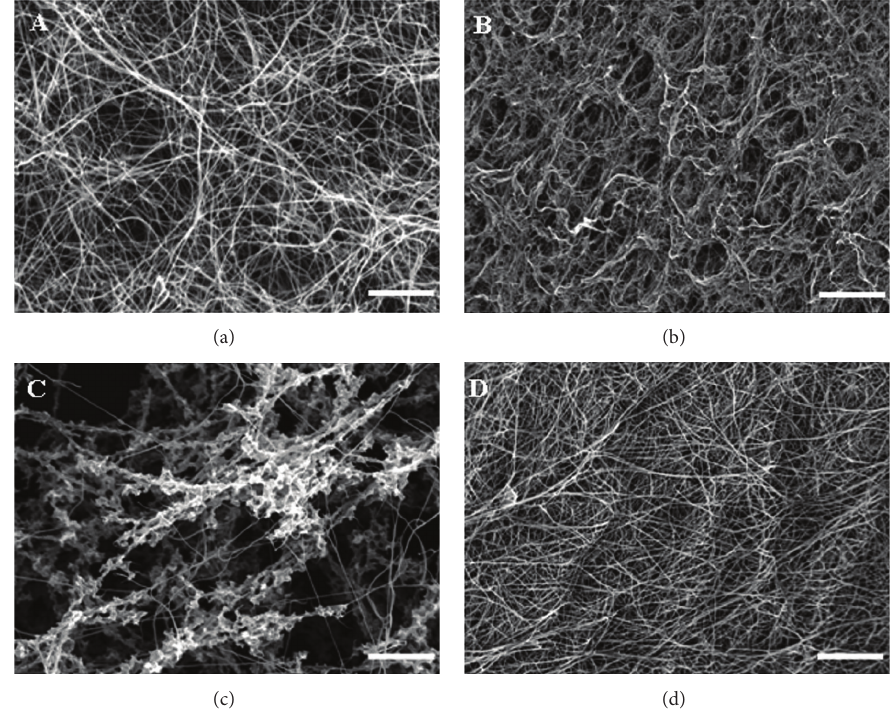
Figure 3: Representative SEM images of fibrin clots formed by modified and control fibrinogens. Control fibrinogen (a) and fibrinogen modified by (b) MDA, (c) NaOCl, and (d) SIN-1. Images were obtained from the clots formed by fibrinogen in the final time of modification (MDA 120 min, NaOCl 20 min, and SIN-1 60 min). The scale bar is 5 𝜇